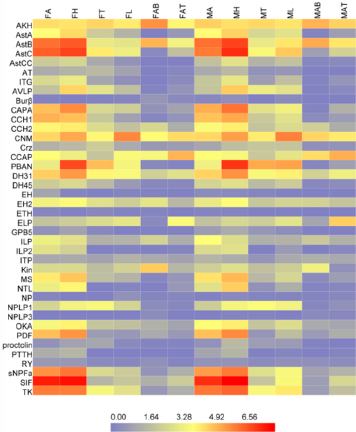
Figure 5. Expression profiles of neuropeptides in various tissues of D. citri based on FPKM values (fragments per kilobase per million reads). The mRNA levels, as represented by log2 (FPKM + 1) values, are shown in a heat map with colors ranging from blue (low expression) to red (high expression). MA, male antenna; MH, male head; MT, male thorax; ML, male leg; MAB, male abdomen; MAT, male abdomen terminal; FA, female antenna; FH, female head; FT, female thorax; FL, female leg; FAB, female abdomen; FAT, female abdomen terminal.